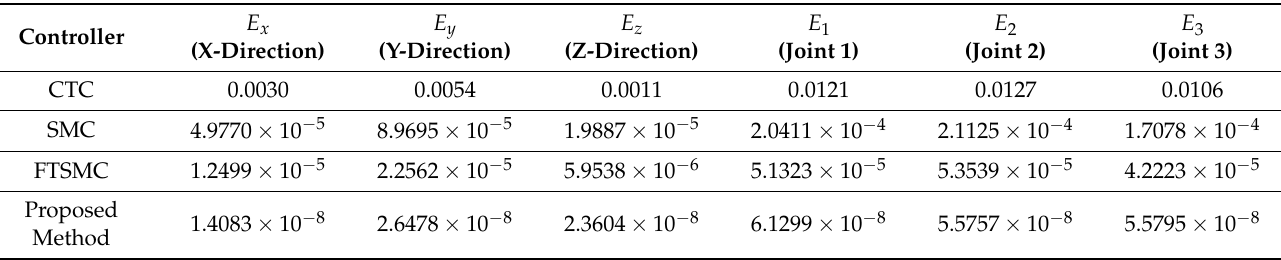
Table 4. RMSEs of four controllers in the first case.